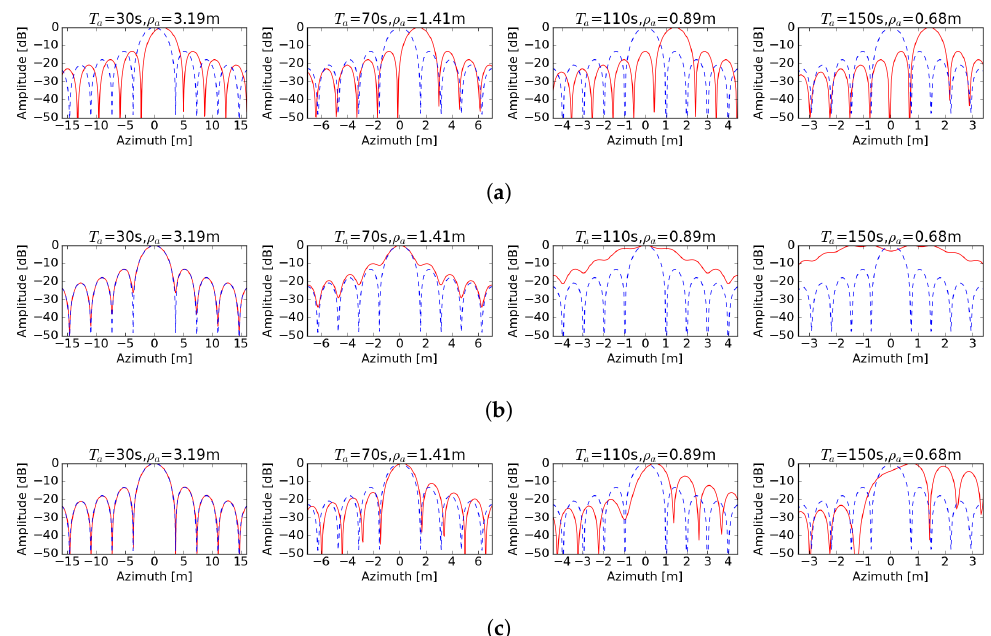
Figure 8. Influences of time variant error on the azimuth impulse response under different integration times with the X band: ( a ) Case 0, ( b ) Case 1, and ( c ) Case 2. The blue dotted line represents the ideal result, and the red solid line represents the influenced result.